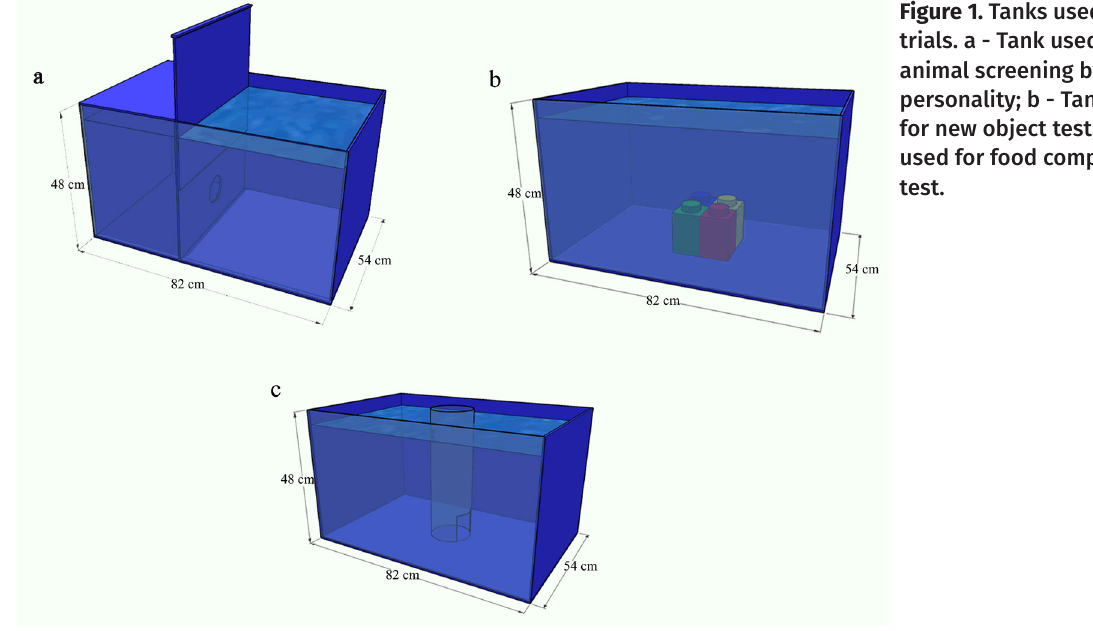
Figure 1. Tanks used in trials. a - Tank used for animal screening by personality; b - Tank used for new object test; c - Tank used for food competition